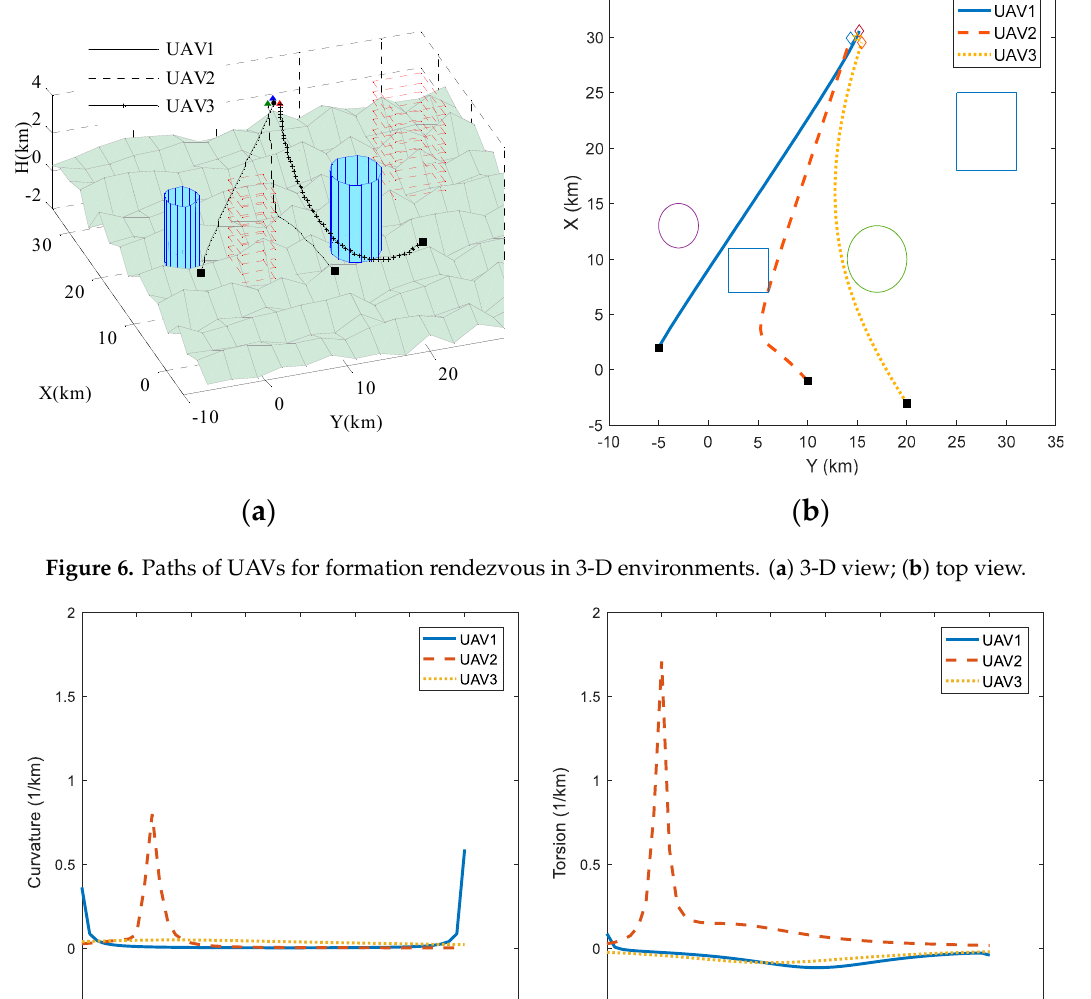
Figure 6. Paths of UAVs for formation rendezvous in 3-D environments. ( a ) 3-D view; ( b ) top view.